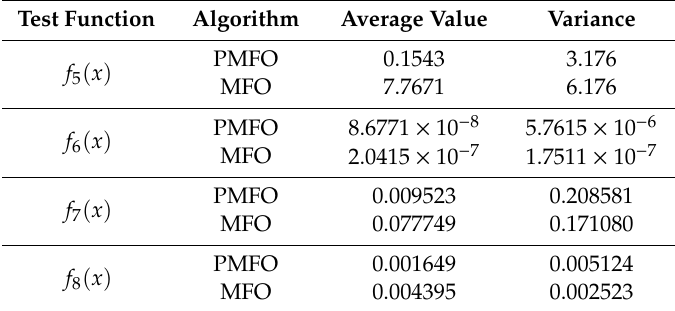
Table 8. Results of multimodal test functions.